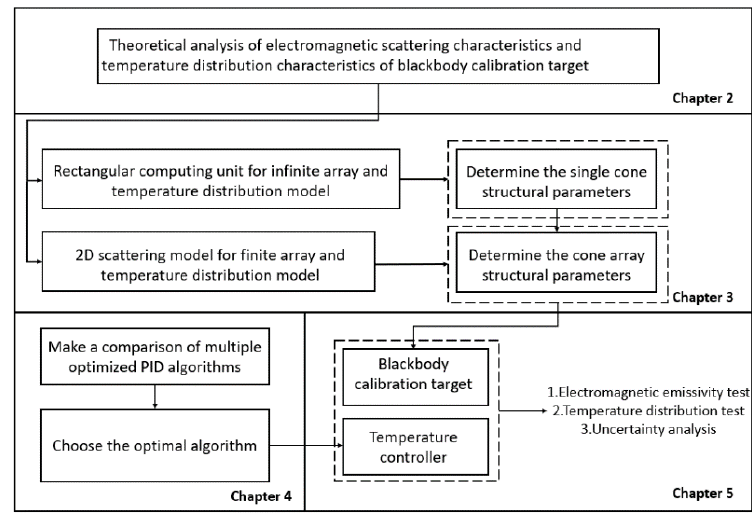
Figure 1. The overall design of this paper.